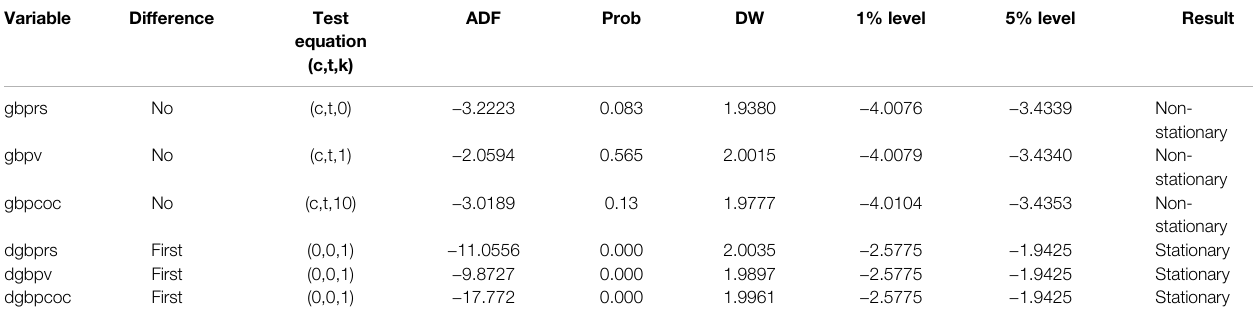
TABLE 1 | Result of the ADF test for US dollar/UK pound.